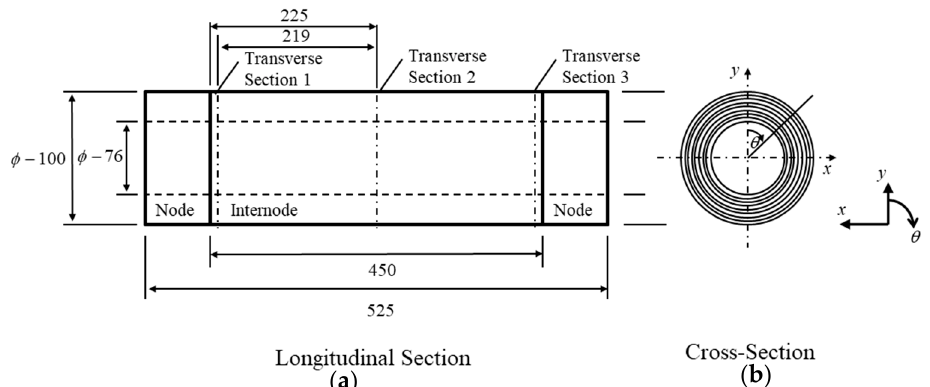
Figure 10. ( a ) Longitudinal section showing dimension outline of solid cylindrical model and ( b ) coordinate system in cross-sectional view.